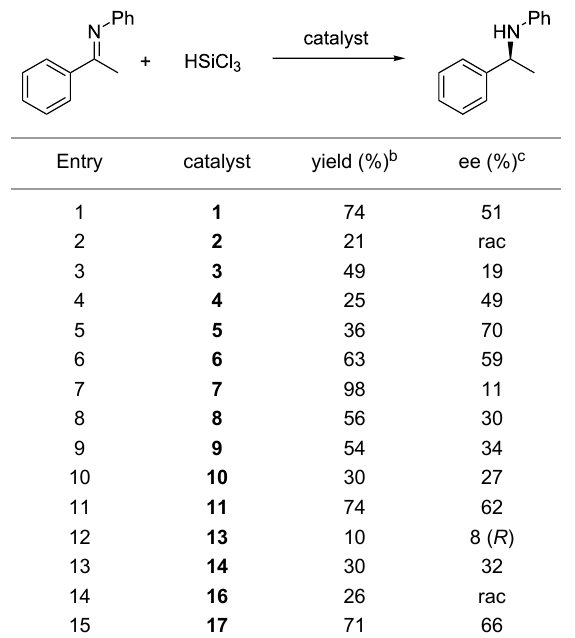
reflux for 4 hours. The catalytic efficiency of these catalysts was evaluated in the stereoselective reduction of the N- phenyl imine of acetophenone (Table 2).